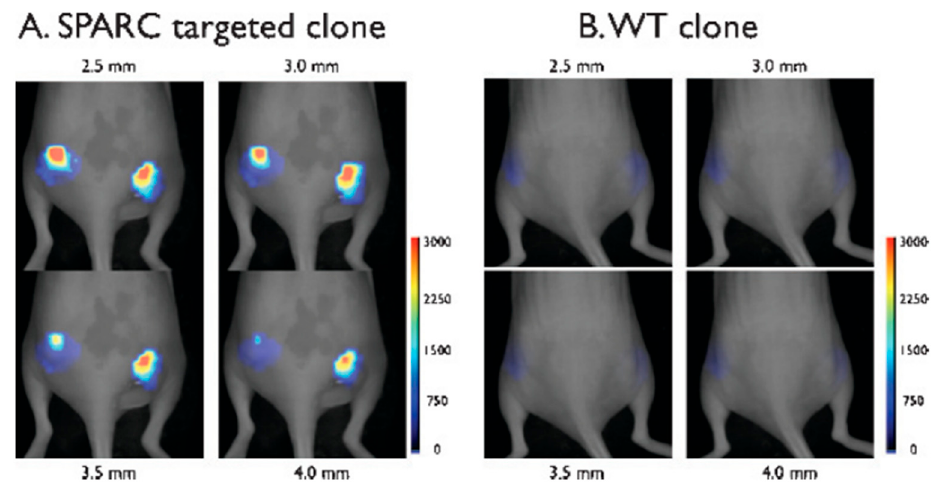
Figure 12. In vivo fluorescent labeling of tumors in mice thanks to modified M13 bacteriophages ( A ) and negative control wild-type phage ( B ) [106]. Reprinted from [106], Copyright 2006, with permission from Elsevier.